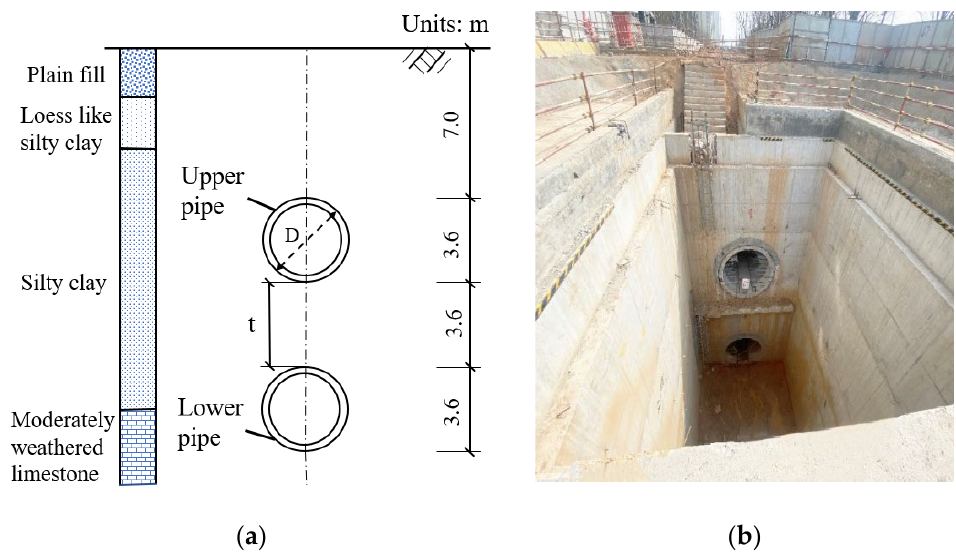
Figure 1. Layout plan of Pipe jacking. ( a ) Vertical arrangement of the pipe jacking engineering and soil distribution; ( b ) Section view of vertical double-layer pipe jacking completed construction.